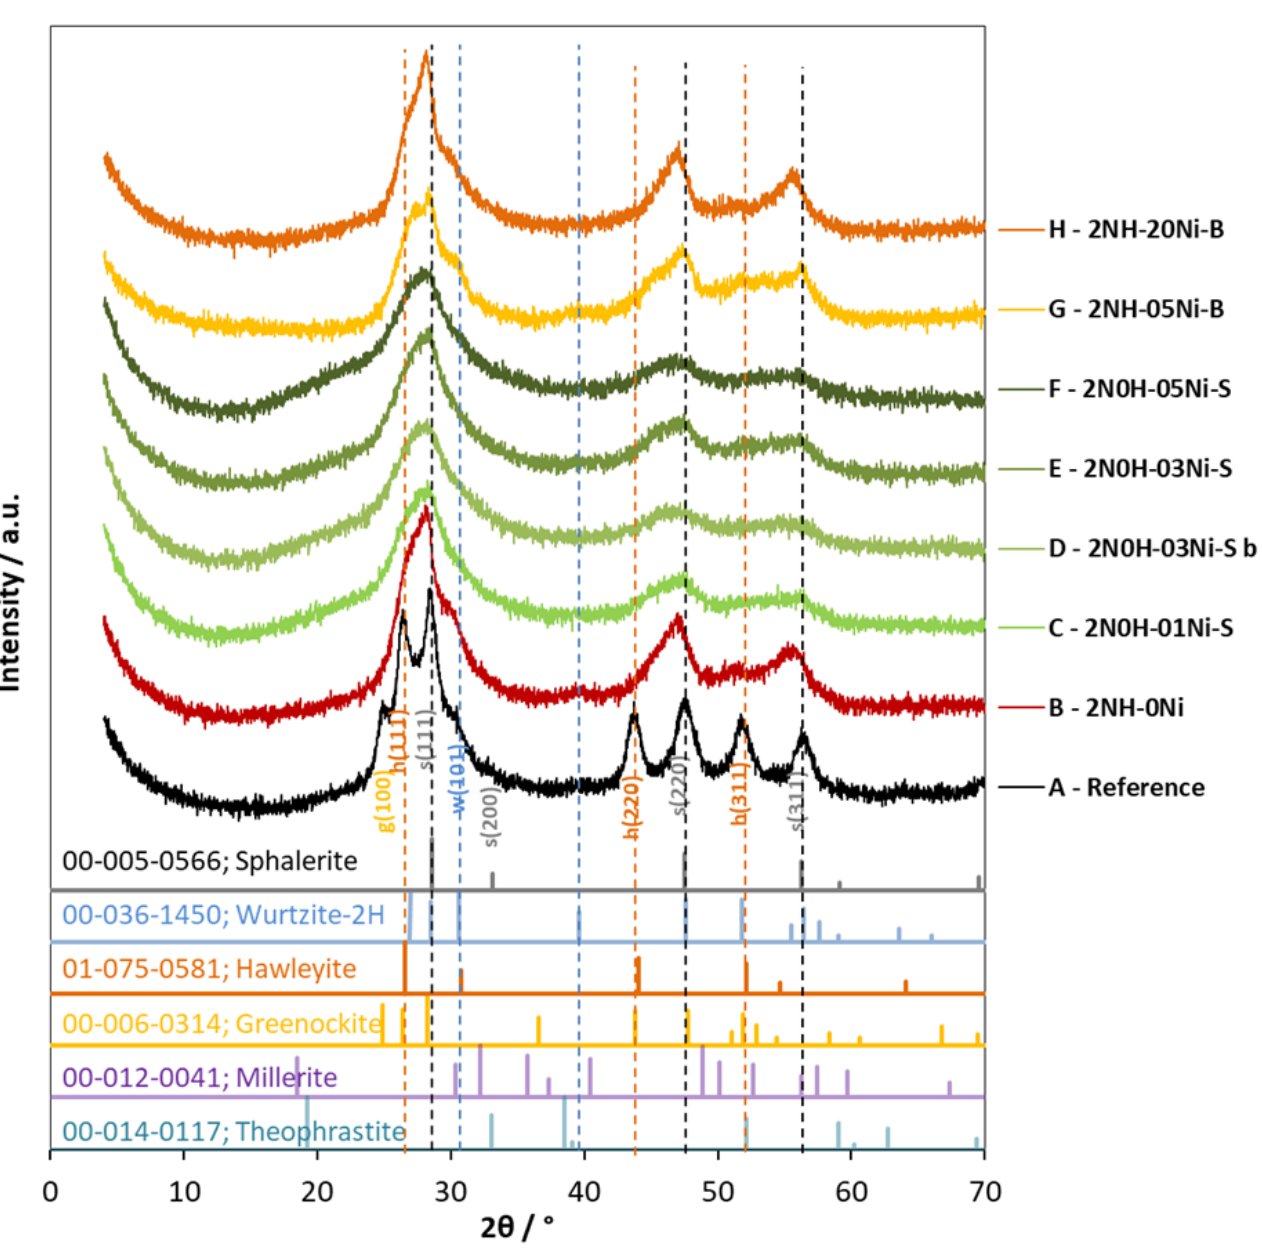
Figure 4. XRD patterns of photocatalysts prepared in the presence of 2-fold excess of ammonia (“2N”). ( A ) Mixture of ZnS and CdS (in 3:1 molar ratio) synthesized and hydrothermally treated (“H”) in the same way as other catalysts. ( B ) Hydrothermally treated unmodified and ( G ) and ( H ) hydrothermally treated and modified with 0.5% and 2.0% Ni(II) in the bulk, respectively. ( C – F ) Hydrothermally not treated (“0H”) and modified with 0.1%, 0.3%, 0.3%, and 0.5% Ni(II) on the surface, respectively. ( D ) was measured before (“b”) illumination, while all others were measured after illumination. (For the sake of unambiguity, besides the designation letter, also a more detailed code indicating the preparation conditions is also given for each pattern) The dashed vertical lines designate the characteristic peaks of cubic sphalerite (black), hawleyite (orange), and hexagonal wurtzite (blue).